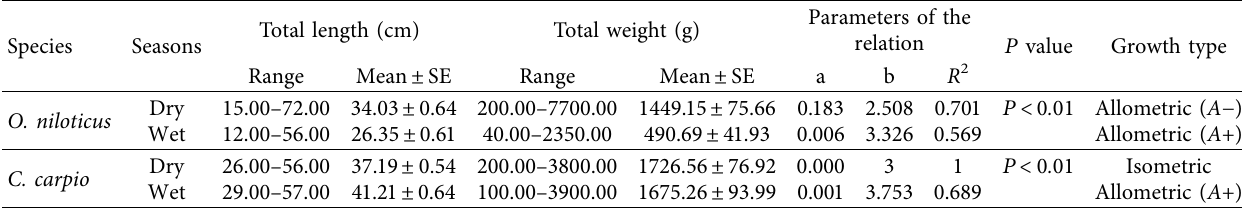
Table 3: Descriptive statistics and species-wise seasonal changes in parameters of the growth curves based on W � aL b plotting of the current